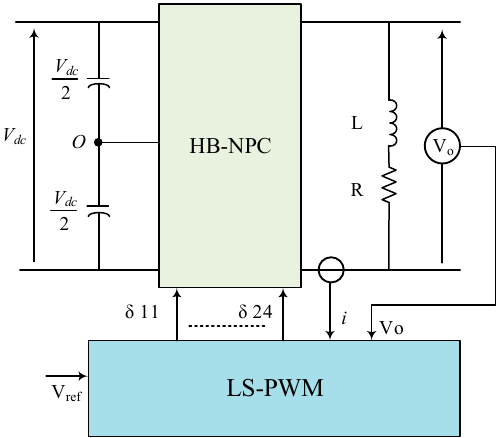
Figure 1. Studied system based on an five-level H-Bridge Neutral Point Clamped (HB-5L-NPC) inverter.